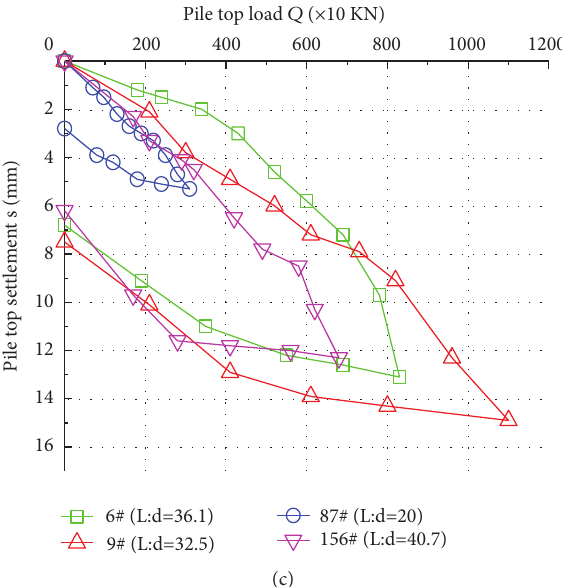
Figure 2: Diagrams of the relevant data of pile foundation in this project: (a) diagrams of pile foundation location layout of building, (b) detail diagrams of pile foundation, and (c) the Q -s curve of pile foundation for each pile foundation.